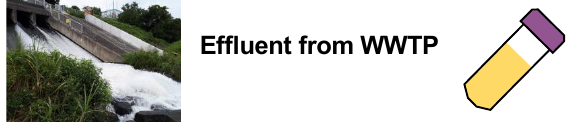
(ST) are summarized in Table S3. Eighteen CPB isolates (six bla IMP -positive, eight bla KPC - Fig. 1. Experimental procedure for potential ESBL producing organisms. positive, and two bla NDM -positive) were identified (Table 1).